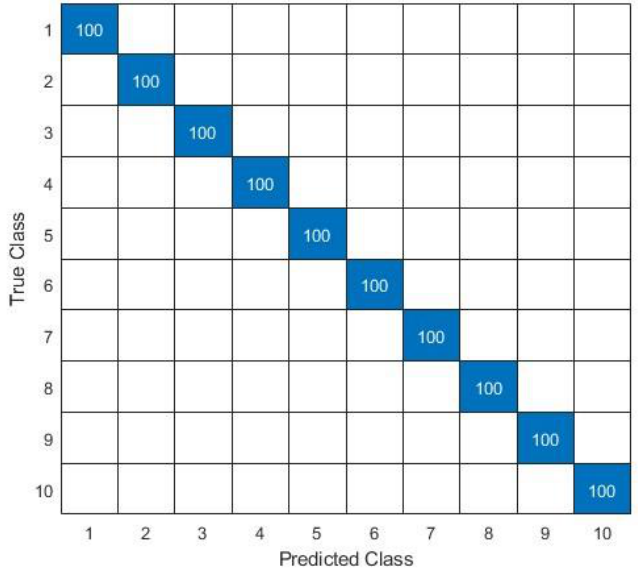
Figure 21. Confusion matrix of unknown data.